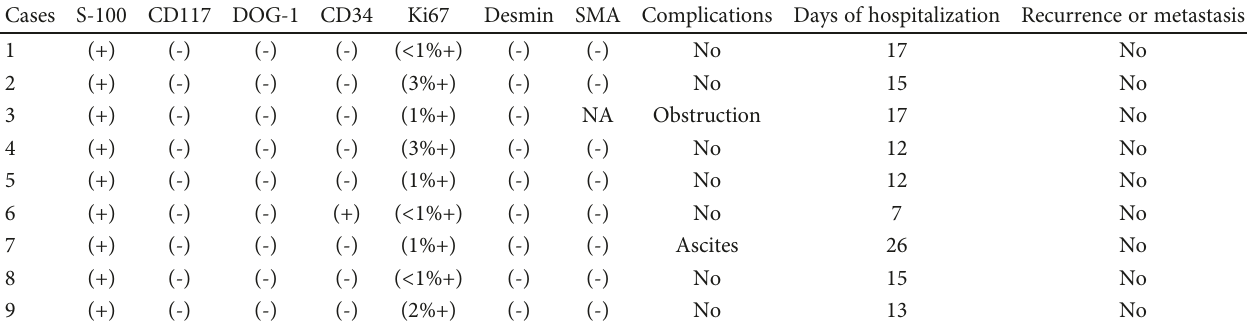
Table 4: Histopathological immunohistochemistry results and prognosis of patients with intestinal schwannoma after surgery. Cases S-100 CD117 DOG-1